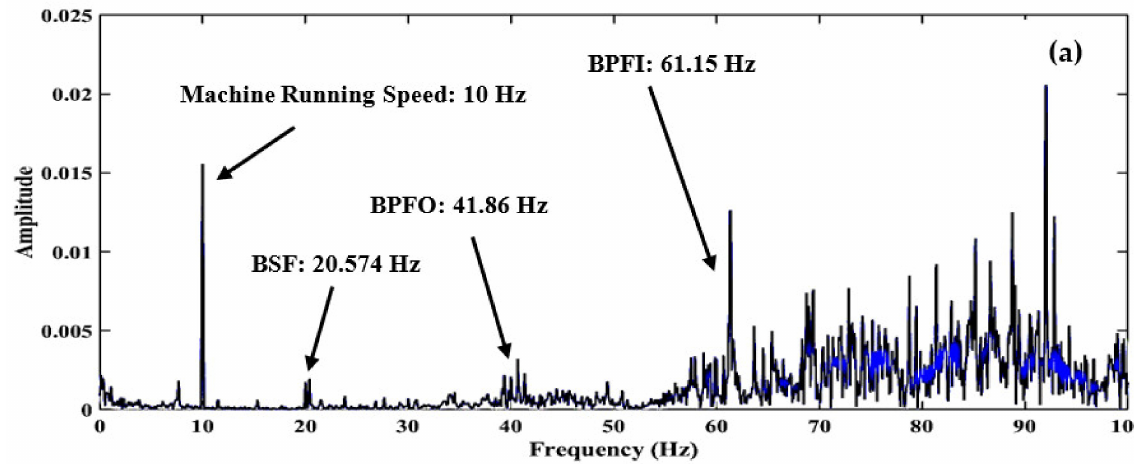
Figure 8. Bearing with compound fault.